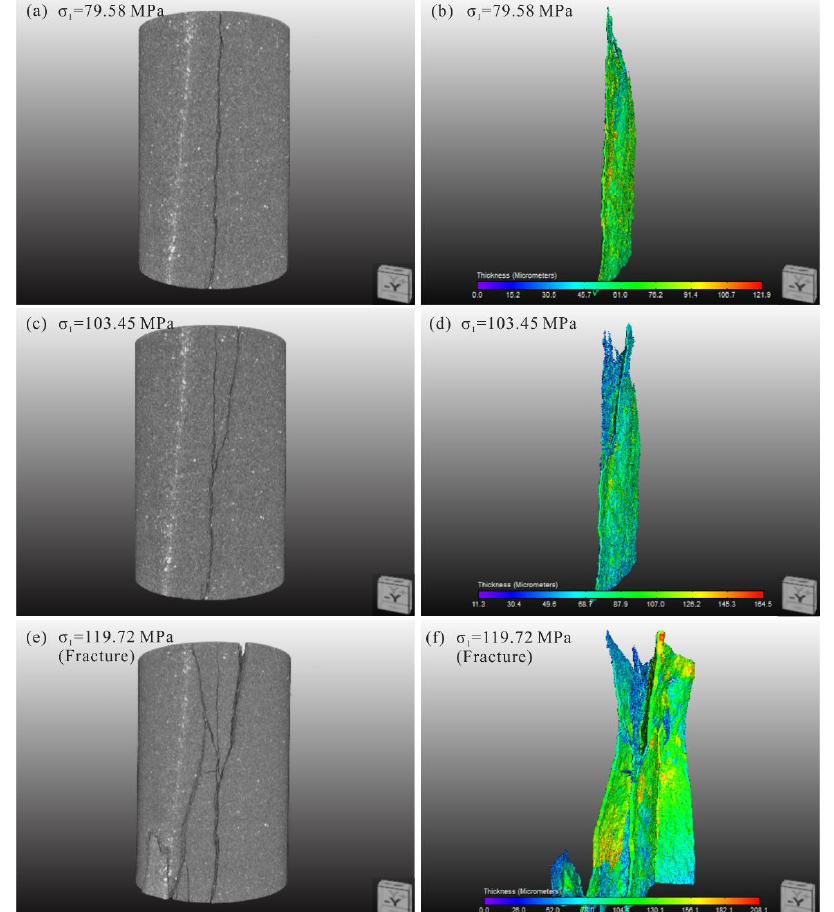
Figure 6. Crack propagation patterns at different load stage in SZA3. ( a ) Specimen at σ 1 = 79.58 MPa; ( b ) Crack at σ 1 = 79.58 MPa; ( c ) Specimen at σ 1 = 103.45 MPa; ( d ) Crack at σ 1 = 103.45 MPa; ( e ) Fractured specimen; ( f ) Crack of the fractured specimen (after σ 1 = 119.72 MPa). In ( a , c , e ), dark area represents cracks. In ( b , d , f ), rainbow colors represent the thickness value ranges from low to high, and red means highest. All crack images are in the same orientation.